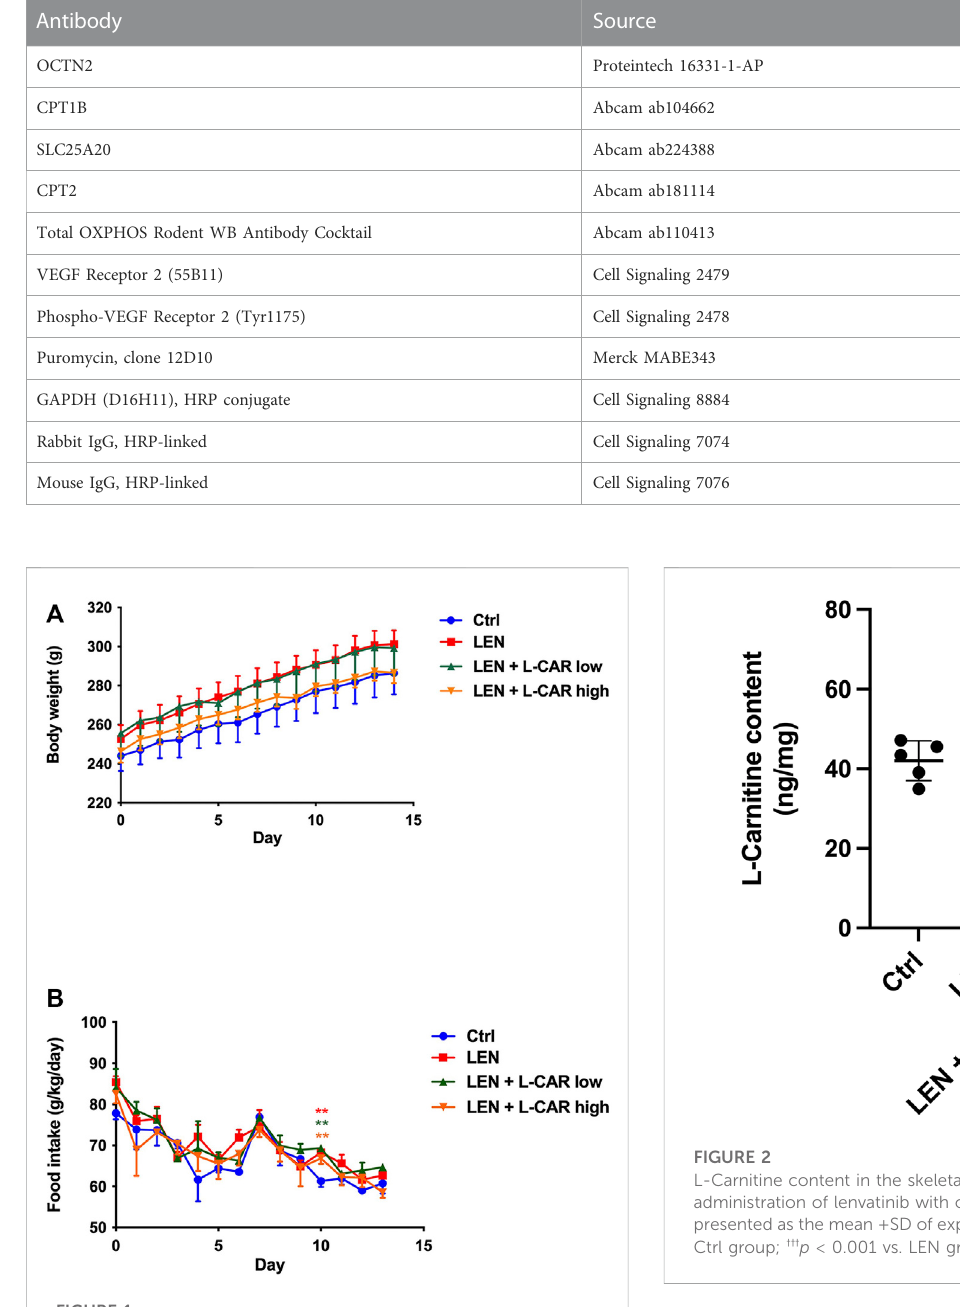
FIGURE 1 Effects of lenvatinib and L-carnitine supplementation on body weight (A) and food intake (B) . Lenvatinib mesylate (2 mg/kg), L-carnitine (150 or 300 mg/kg), and/or vehicle were orally administratedoncedailyfor14 days toratsinthelenvatinib (LEN; n = 5), lenvatinib + low-dose L-carnitine (LEN + L-CAR low; n = 5), lenvatinib + high-dose L-carnitine (LEN + L-CAR high; n = 6), or control (Ctrl) group ( n = 5), respectively. Data are presented as the mean ± SD. ** p < 0.01 vs . Ctrl group.